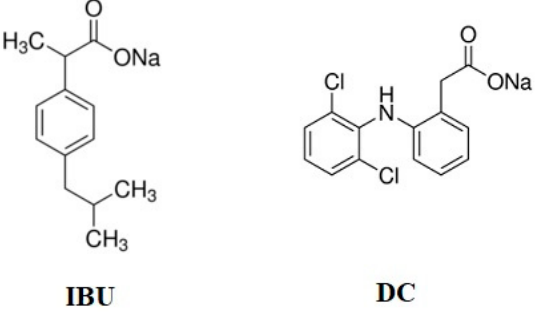
Figure 2. The structural formulas of used analgesics [34].